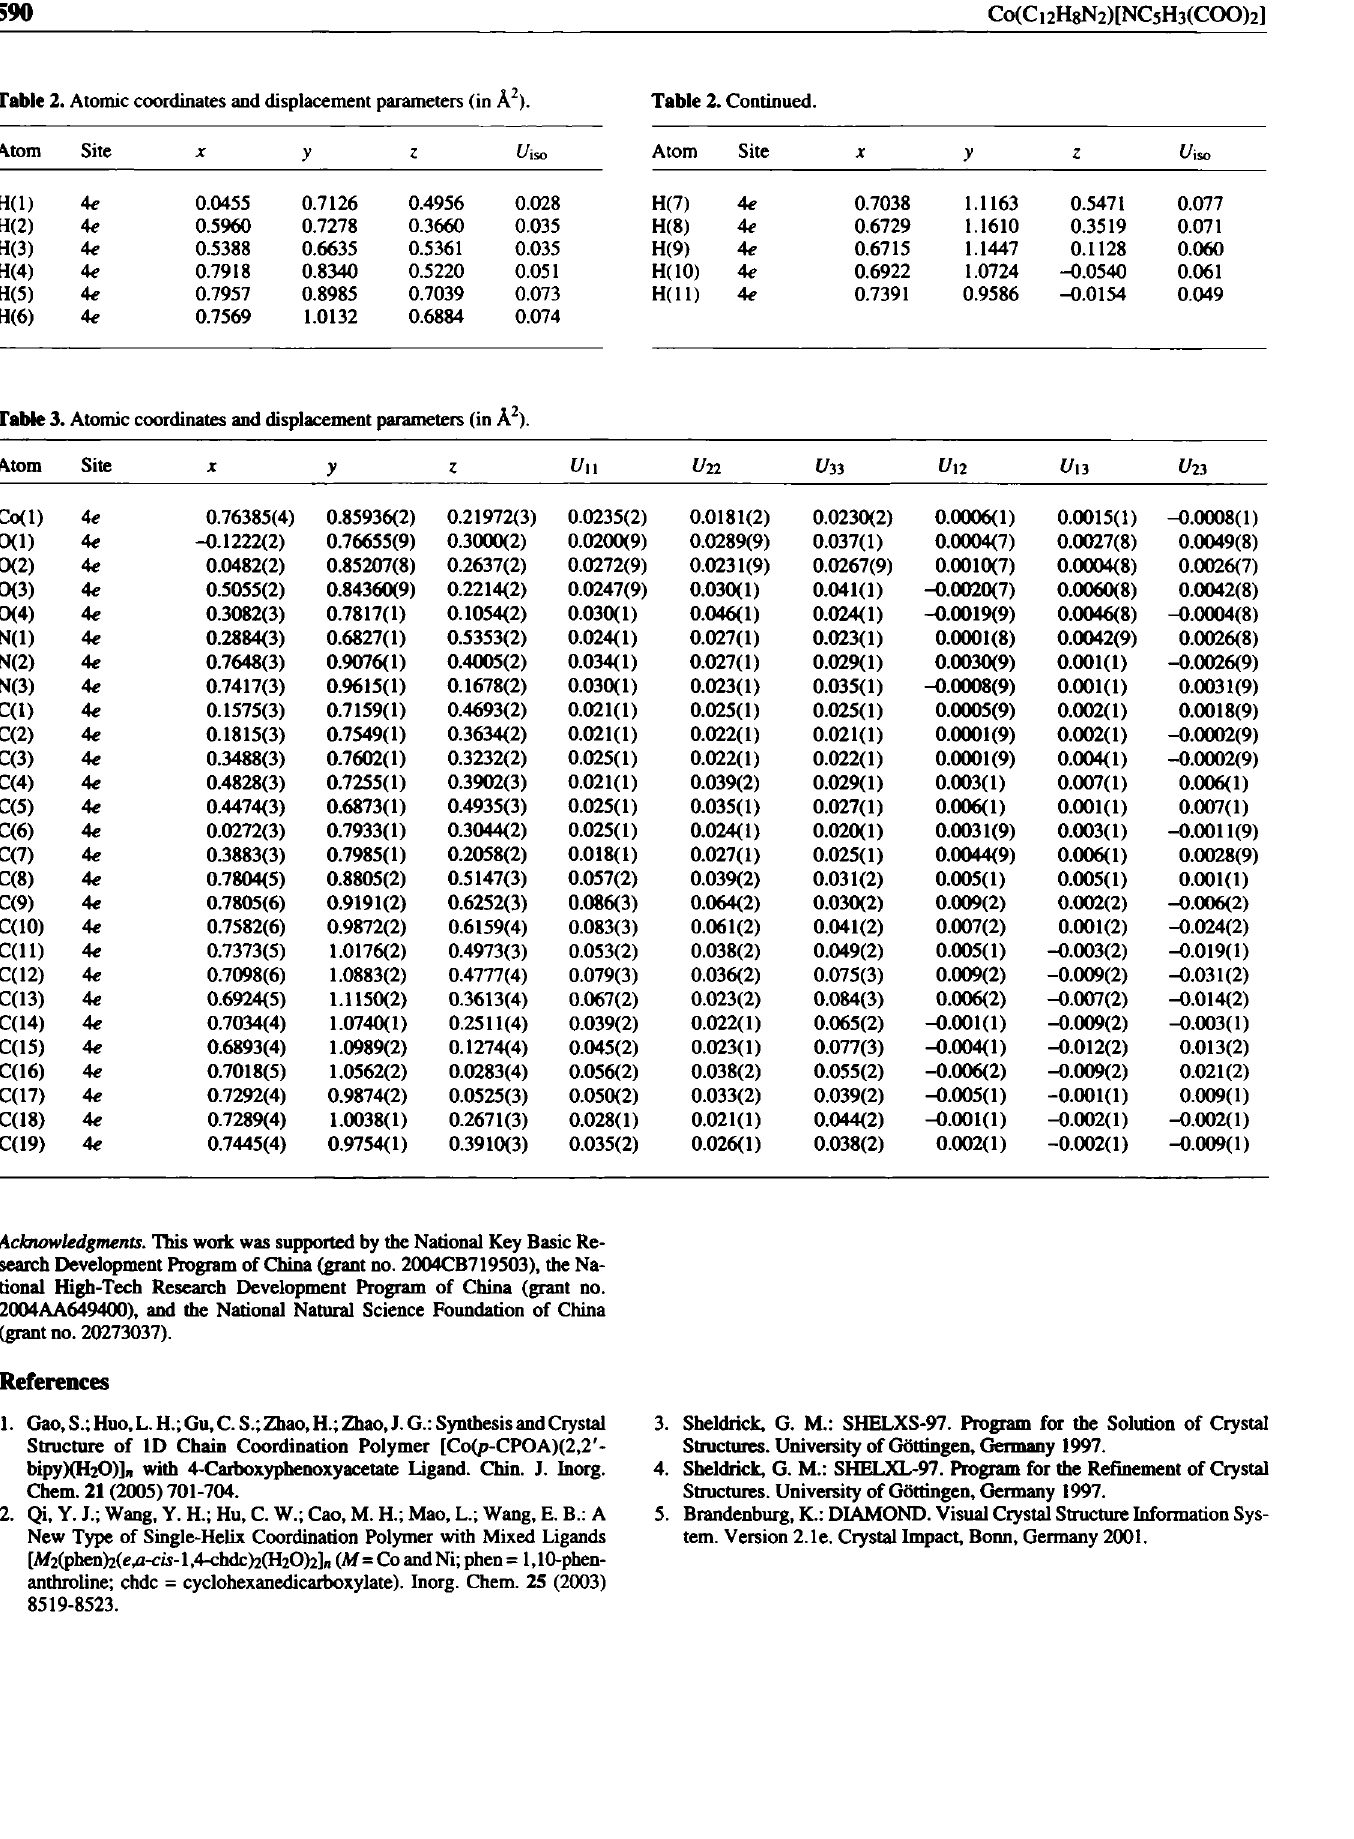
Table 3. Atomic coordinates and displacement parameters (in A 2